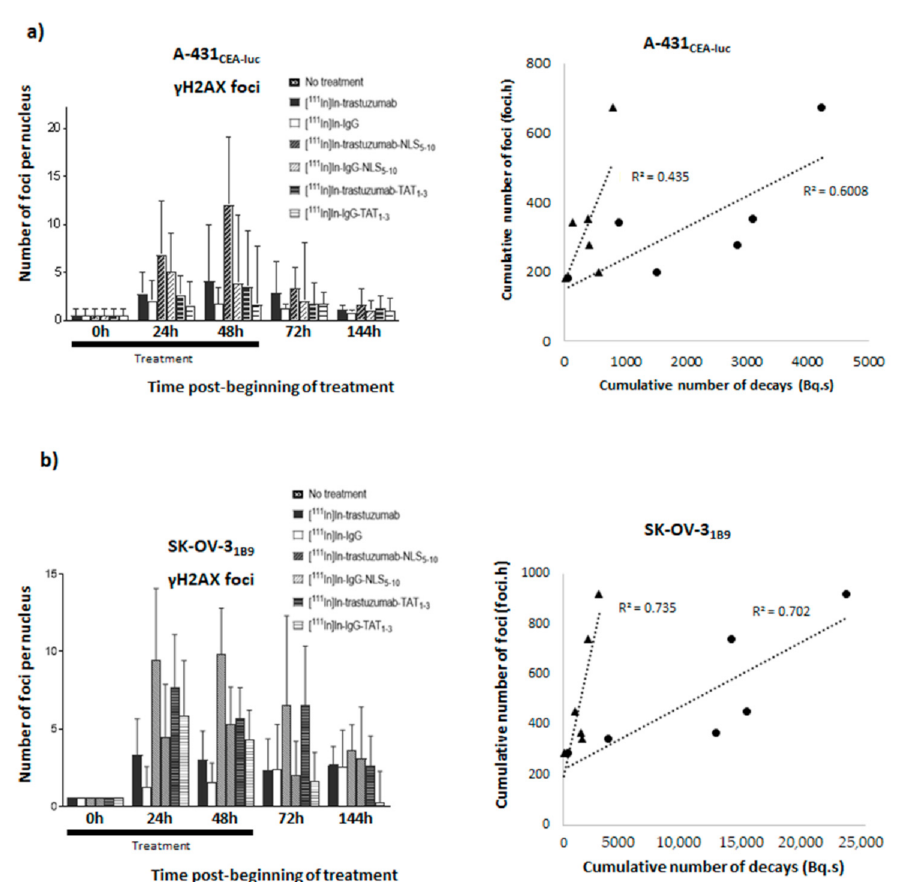
Figure 7. Quantification of γ H2AX foci. γ H2AX foci formation was evaluated at various time points (24 h, 48 h, 72 h, and 144 h) in ( a ) A-431 CEA-luc and ( b ) SK-OV-3 1B9 cells after incubation with 4 MBq/mL of each RIC. Briefly, cells were fixed, permeabilised, and incubated with an anti- γ H2AX antibody followed, after washing, by a goat anti-mouse IgG FITC conjugate. Images were acquired using a × 63 or × 40 objective, and at least 100 nuclei were analysed per immunoconjugate. Data are the mean ± SEM. The cumulative number of γ H2AX foci (foci.hour) was expressed as a function of the cumulative number of decays (Bq.s) in the nucleus (triangle markers) and in the whole cell (circle